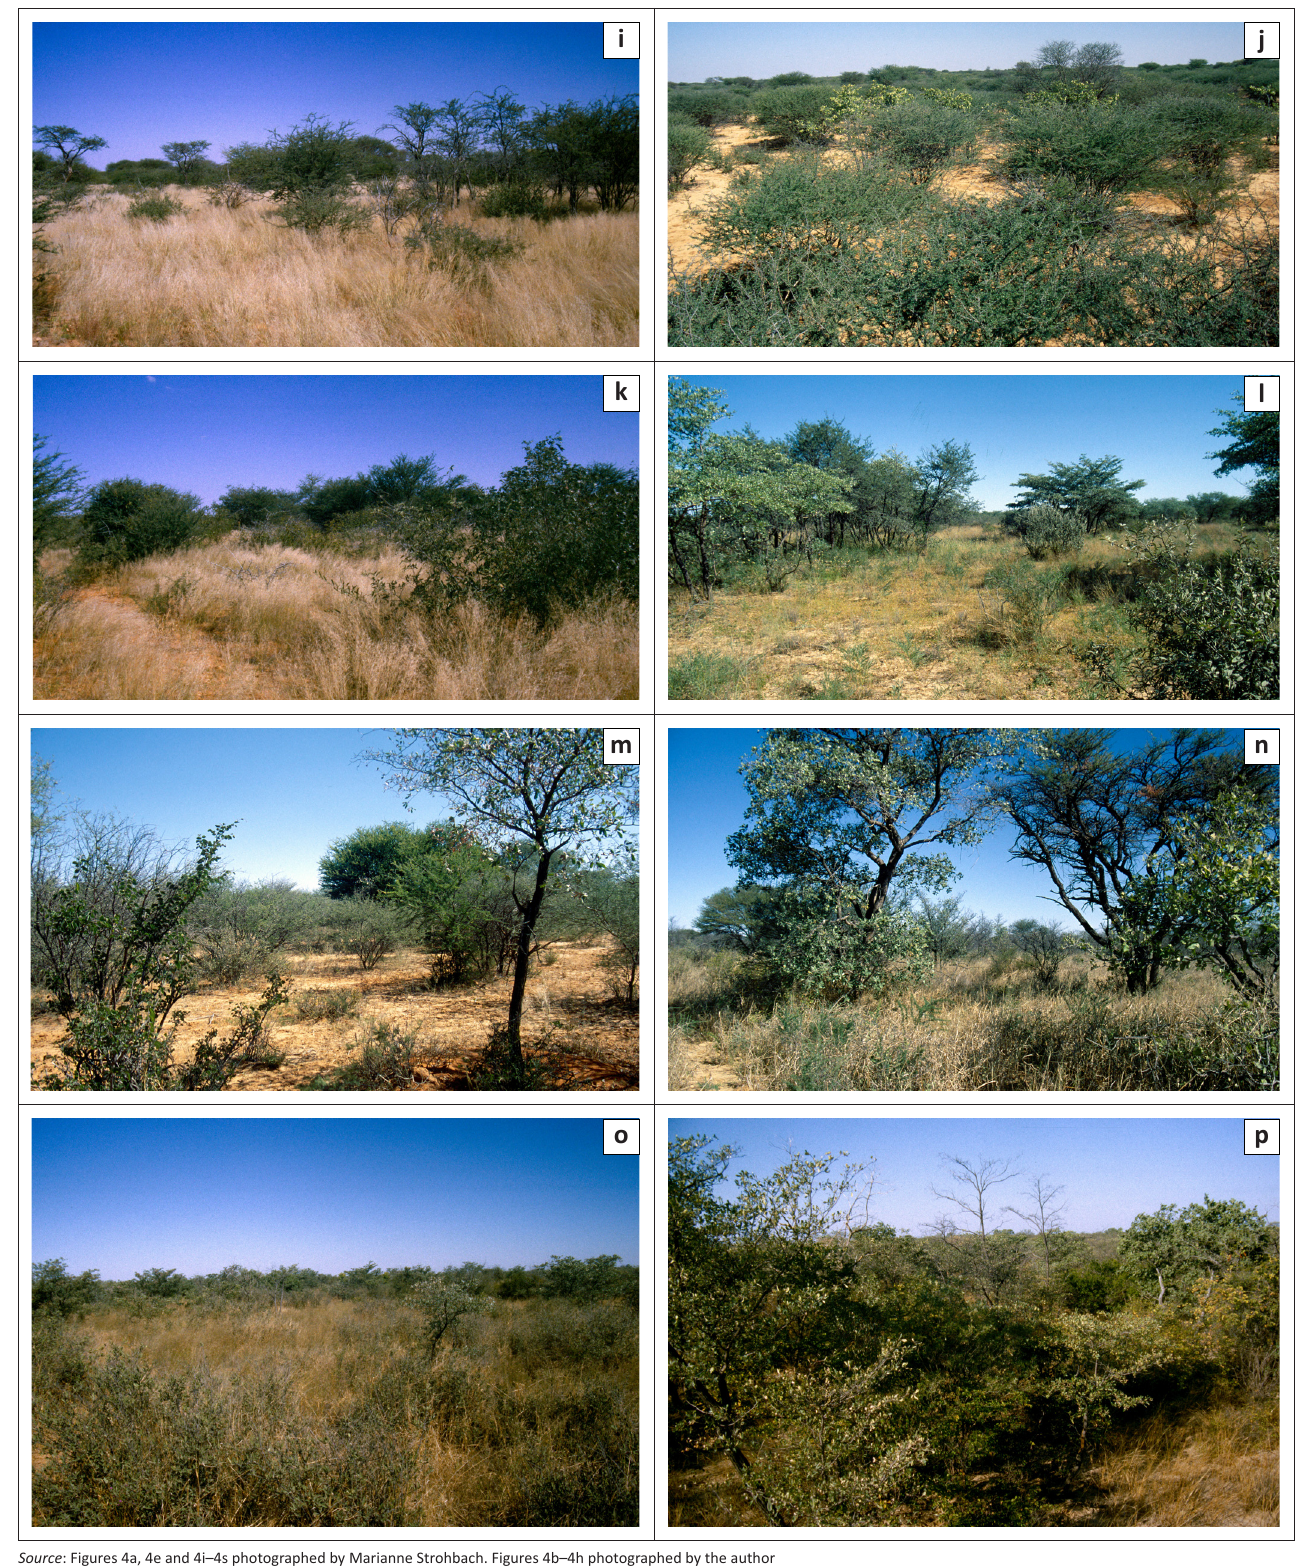
FIGURE 4 (Continues...): Typical examples of various associations and subassociations, (a) Acacio fleckii–Terminalietum prunioidis , (b) Acacio tortilis–Combretetum imberbis , (c) Ptycholobio biflori–Acacietum luederitzii , (d) Eragrostio echinocloideae–Eriocephaloetum luederitziani , (e) Acacio melliferae–Catophractetum alexandri ,